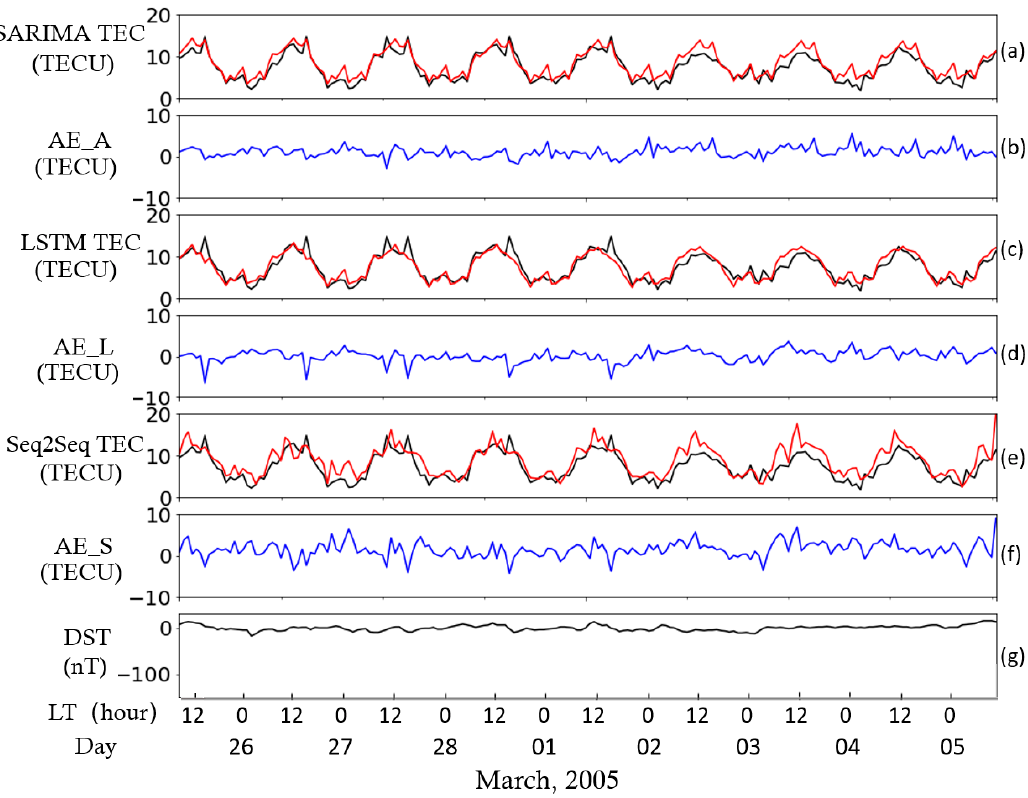
Figure 4. TEC observation and model predictions during the geomagnetic quiet period from 25 February to 5 March 2005. Panels ( a ), ( c ), and ( e ) are the measured TEC data (black) and the predicted TEC data (red) by the autoregressive integrated moving average (ARIMA), LSTM, and Seq2Seq methods. Panels ( b ), ( d ), and ( f ) are the absolute errors (blue) between predicted TEC and actual TEC. Panel ( g ) is the geomagnetic disturbance index Dst.